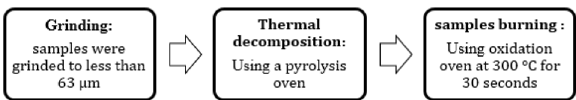
Fig. 2 TOC test procedures